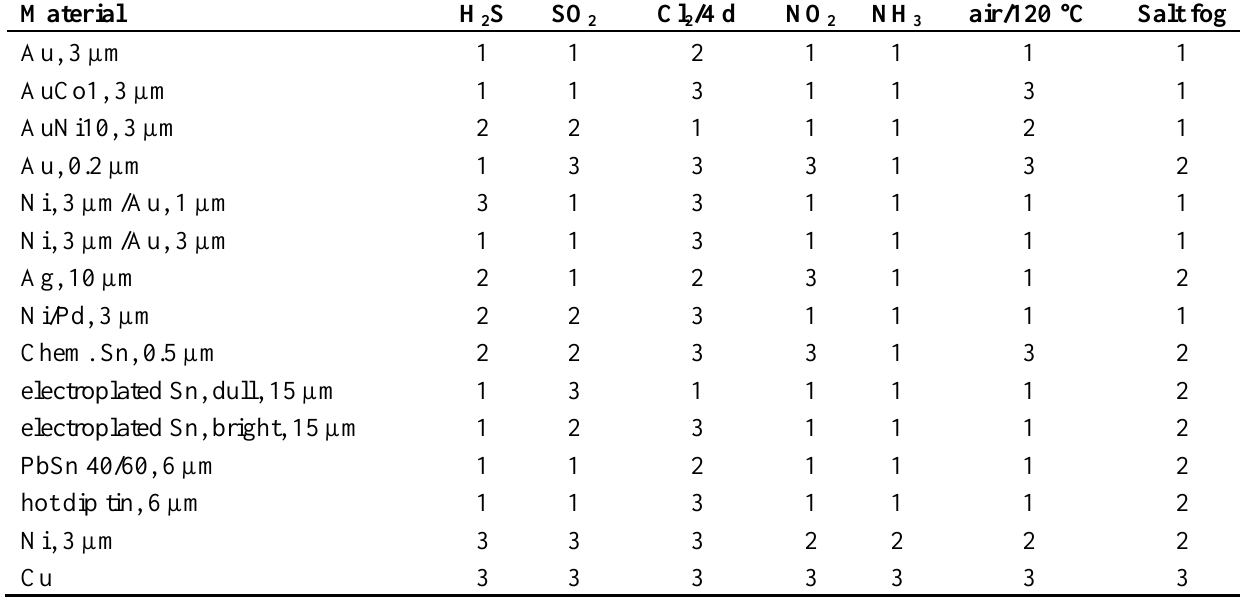
Table 1. Corrosion resistance of selected metals: 1 = high; 2 = fair; 3 =